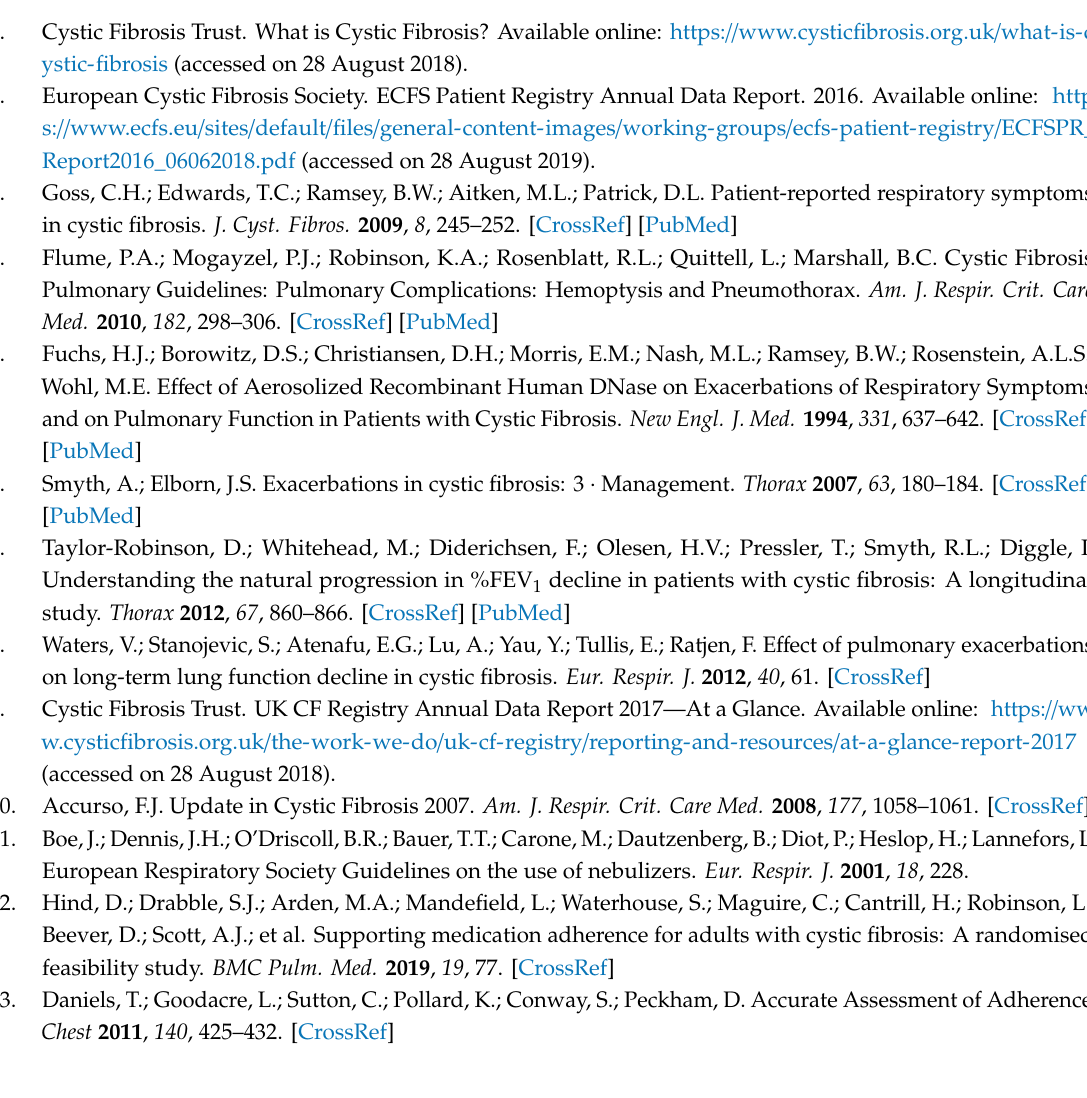
Figure S1: CONSORT diagram; Figure S2: Cross-correlation